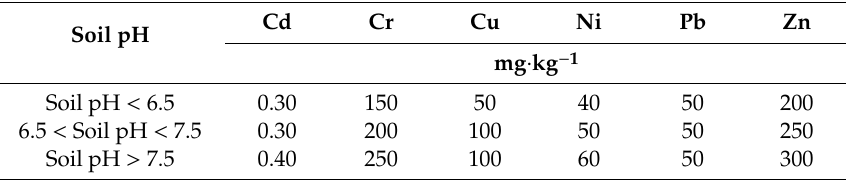
Table 1. The HM limits based on the Environmental Quality Evaluation Standard for Farmland of Greenhouse Vegetables